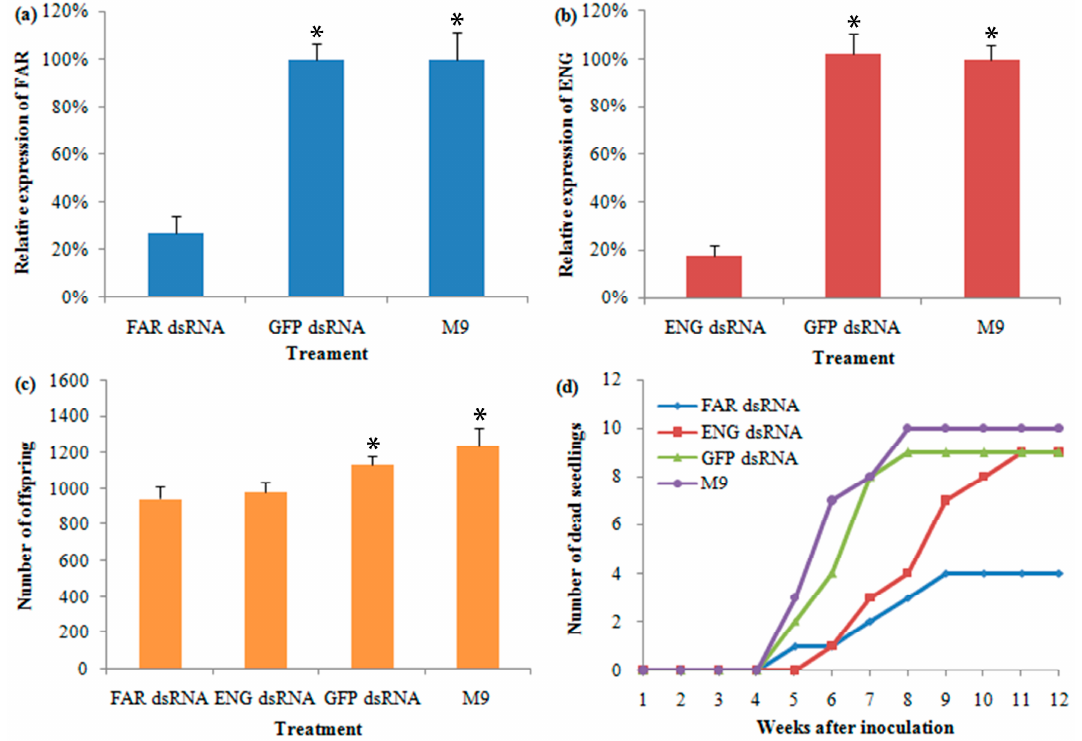
Figure 4. Influence of RNAi knockdowns of fatty acid- and retinol-binding protein ( FAR ) and β -1,4-endoglucanase ( ENG ) genes in Bursaphelenchus mucronatus ( B. mucronatus ). ( a ) mRNA expression levels of FAR gene in B. mucronatus after exposure to FAR dsRNA- and GFP dsRNA-soaking buffers (expression level of M9 was taken as 100%); ( b ) mRNA expression levels of the ENG gene in B. mucronatus after exposure to ENG dsRNA-soaking buffers; ( c ) influence of RNAi on the reproduction efficiency of B. mucronatus ; ( d ) the cumulative mortality rate of Pinus thunbergii seedlings after inoculation with differently treated nematodes. Error bars show standard deviations. Asterisks (*) indicate a significant difference exists between target dsRNA treatments and controls ( p -value < 0.001).